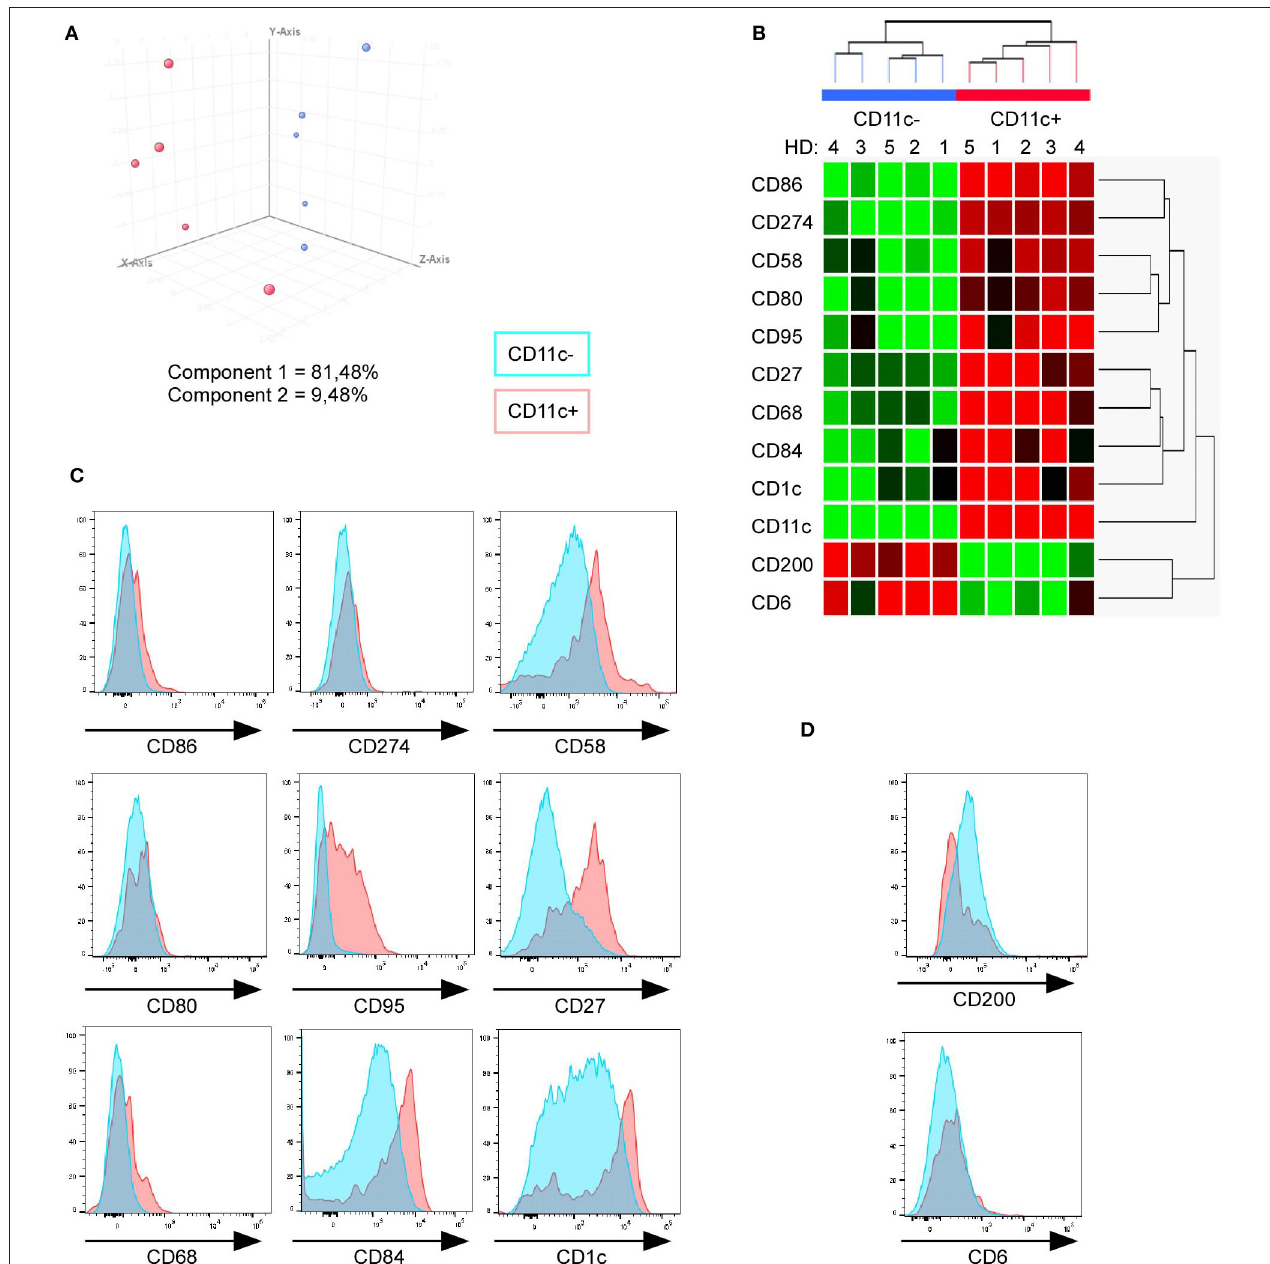
FIGURE 3 | Minimal combination of 12 cell surface markers perfectly discriminate CD11c + from CD11c − B cells. (A) Principal component analysis of 10 samples (paired CD11c + and CD11c − B cells from five HD) performed with gene expression level of the 12 mRNA corresponding to cell surface markers among the 512 DEG between CD11c + (red dots) and CD11c − (blue dots) B cells. (B) Hierarchical clustering shows that a minimal combination of 12 transcripts is sufficient to perfectly discriminate both populations. (C,D) FACS analysis of CD11c + , including CD11c hi (red) and CD11c − (blue), was performed to validate this combination of markers at the protein level (one representative result of three independent